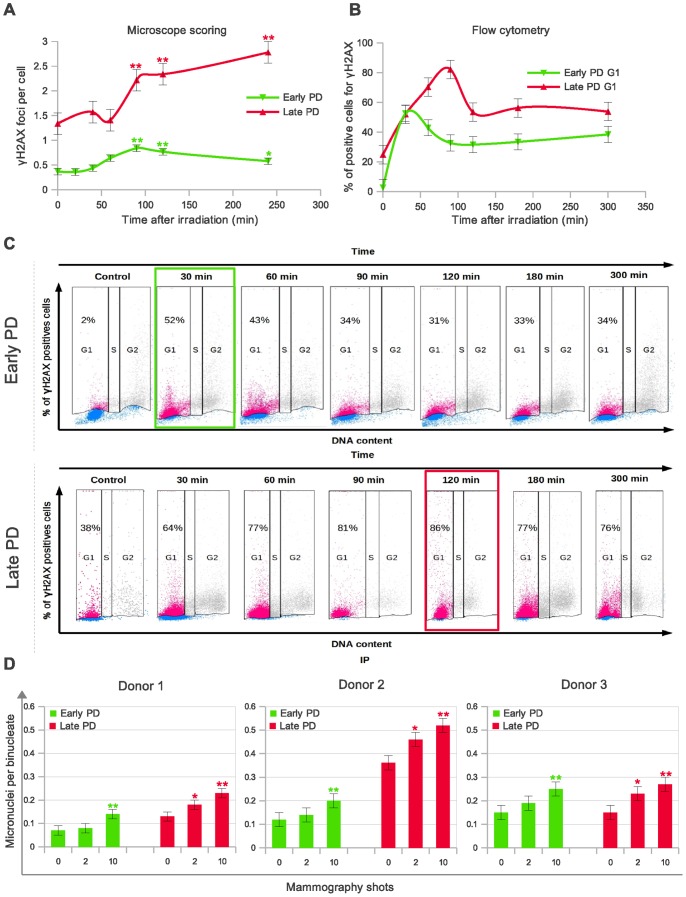
DNA double strand breaks (DSBs) measured by detection of γH2AX induction in late PD HMECs by mammogram X-rays last longer than in early PD HMECs.
A. Time-dependence of γH2AX foci formation and disappearance measured by direct microscopic visualization. The foci were counted in 1000 cells per each time and cell subpopulation group. Error bars signify standard error. Simple asterisk (*) refers to statistically significant difference p<0.05 and double asterisk (**) refers to highly significant difference p<0.0001. Mann Whitney test was performed in all samples. B. Time-dependent flow cytometric bivariant detection of propidium iodide (PI)-and γH2AX. Histogram showing the kinetics of γH2AX appearance and disappearance measured by flow cytometry. For early PD HMECs (green), the maximum percentage of γH2AX positive G1-stage cells was reached at 30 minutes after irradiation, whereas in vitro aged HMECs (red) do not reach maximum until 90 min time-point. A minimum of 10,000 cells and two replicas were analyzed by bivariate flow cytometry for each time-point and cell subpopulation. C. Representative dot-plots illustrate that γH2AX labeling lasts longer in the in vitro aged epithelial cells (red dots indicate positive and blue negative γH2AX labeled cells). Cell cycle is displayed using contour plots and γH2AX labeling using pseudo-color plots. Gating set at 3% increment over unspecific background fluorescence for both control and irradiated HMECs. Percentages of positive γH2AX cells at the G1 cell cycle stage are indicated in each dot-plot. For cytometric analysis, early and late PD HMECs were irradiated with 1Gy γ-rays. D. Mean incidence of micronuclei per cell in early and late PD HMECs derived from three different donors and exposed to 0, 2 and 10 automatic X-ray shots under a mammogram device (24 h after irradiation). The micronuclei were counted in 2000 (donor 1) and 500 (donor 2 and 3) binucleates per group. Error bars signify standard error. Asterisk denotes statistically significant difference in a group of irradiated HMECs compared to the shamirradiated controls of each cell subpopulation (Mann Whitney test). Simple asterisk (*) refers to statistically significant difference p<0.05 and double asterisk (**) refers to highly significant difference p<0.0001.